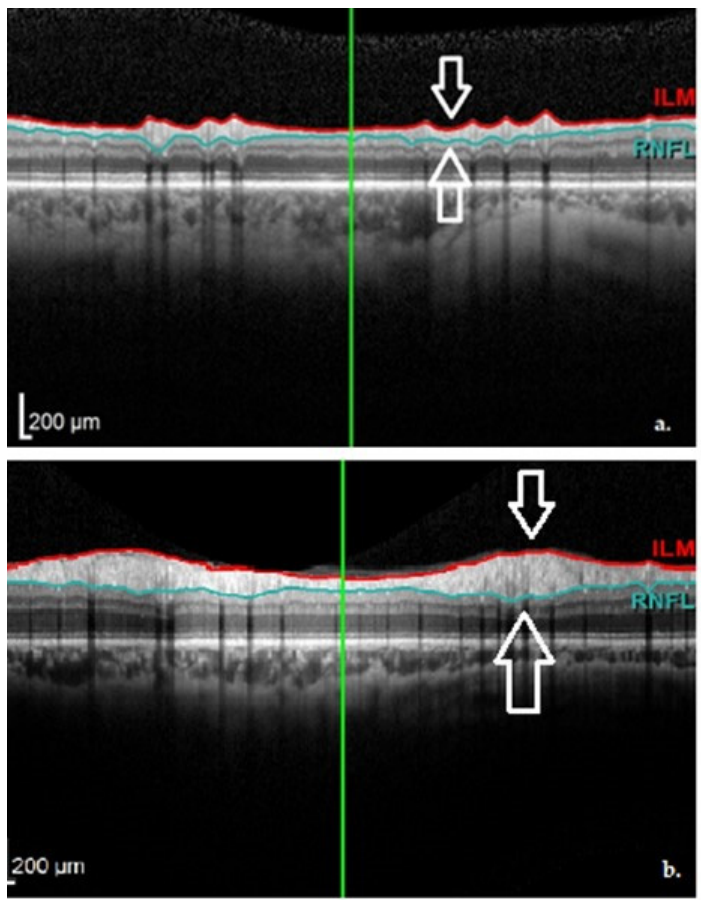
Figure 5. OCT aspect of the RNFL demonstrating thinning in a PD patient ( a ) and normal thickness in a healthy subject ( b ). Images from personal casuistry.